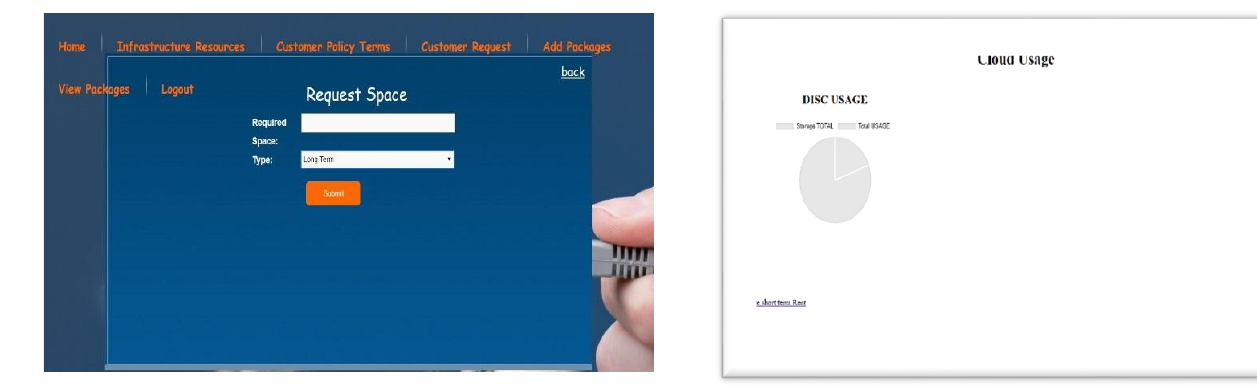
Figure 7. BSP Resource Request Space